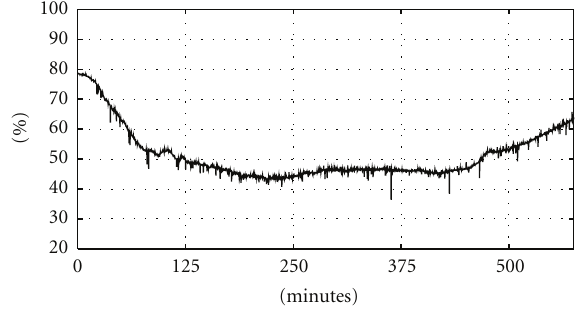
Figure 13: Inside